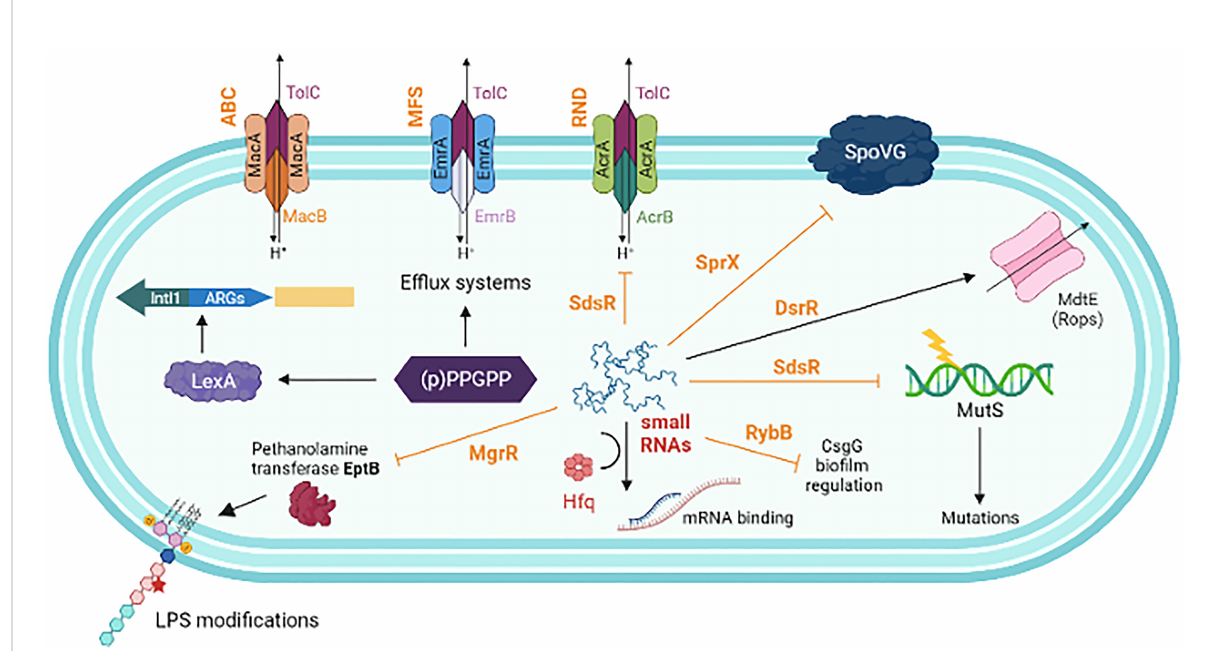
FIGURE 5 A schematic representation showing the interplay of different factors in fl uence in antimicrobial resistance. (p)ppGpp increases the ef fi ciency of HGT, AMR cassette acquisition through IntlI and upregulates the expression of various components of the ef fl ux pumps. Non-coding small RNAs (sRNAs) play a major role in post-transcriptional regulation of gene expression. This includes, negatively regulated targets of MgrR involved in LPS modi fi cation (sensitivity to Polymyxin B); SdsR, repress the expression of tolC , the gene encoding the OMP of many multidrug resistance ef fl ux pumps; SdsR also base-pair with mutS mRNA to repair the DNA after exposure to b -lactams; SprX (a.k.a. RsaOR) in fl uence resistance to glycopeptides by downregulating the SpoVG; DsrA activates the expression of MdtE, which increases ef fl ux system to antibiotic such as oxacillin, cloxacillin, erythromycin, novobiocin etc. RybB negatively in fl uences the expression of csgD transcription, which is the master regulator of bio fi lm formation. sRNAs strongly interact with the co-factor Hfq, which enhances sRNA stability and facilitates base-pairing of sRNAs with multiple target mRNAs. Small RNAs are typed in dark brown. Solid arrows indicate activating interactions and T-arrows indicate inhibiting